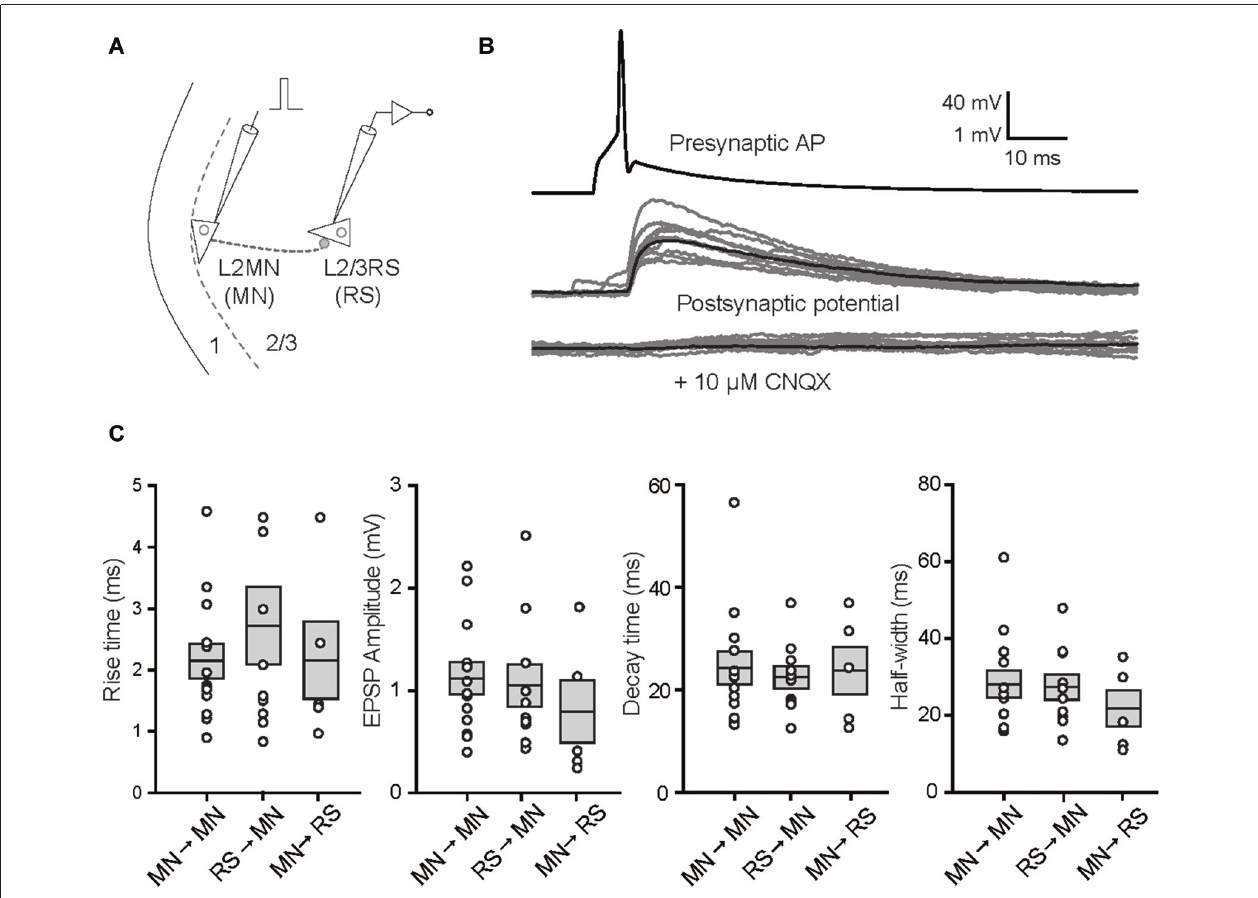
FIGURE 6 | Properties of unitary synaptic responses obtained by multi-patch recording in pairs including a L2MN either as the presynaptic or as the postsynaptic neuron. (A) A schematic illustration of a paired recording; a short current pulse was injected into the presynaptic cell to evoke a single AP. (B) Examples of recordings from both the presynaptic neuron (top) and the postsynaptic neuron before (middle) and after application of 10 µ M CNQX. In the middle and bottom panels, gray traces are from 10 consecutive recordings and the black trace in each of the panels is the average of 35 recordings including the gray traces. The pair is a L2MN → L2MN pair. (C) Comparisons of the rise time, amplitude, decay time and half-width of unitary EPSPs, among L2MN → L2MN, L2/3RS → L2MN and L2MN → L2/3RS pairs. Error bars are SEM. No significant differences were found.